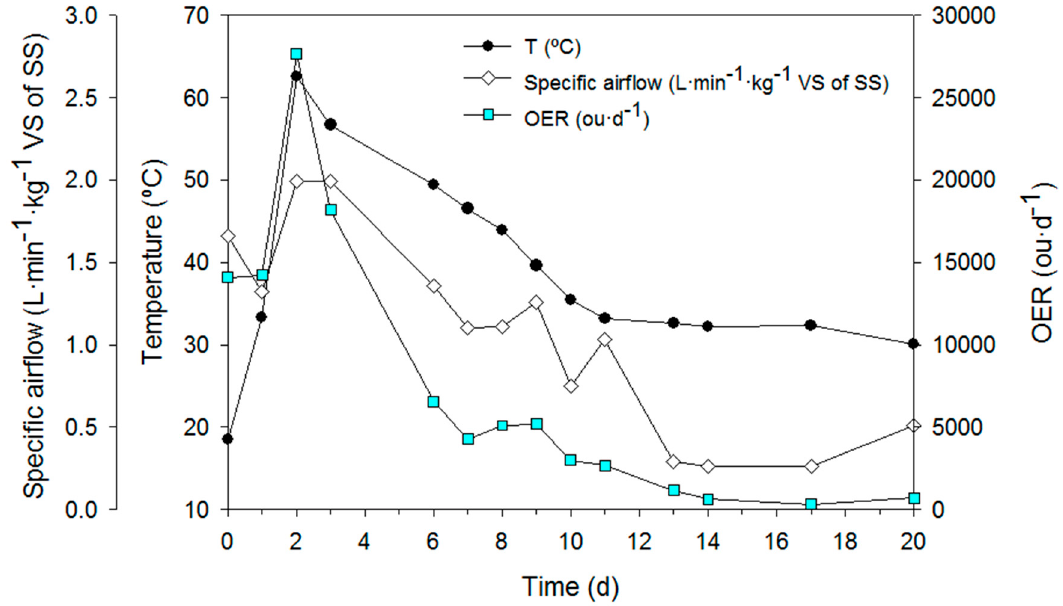
Figure 4. Odour emission rate (OER) profile during the composting process. Black dots represent the average temperature of the reactor (°C); white diamonds represent the specific airflow passed through the reactor (L·min − 1 ·kg − 1 VS of SS); cyan squares represent the odour emission rate (ou·d − 1 ).